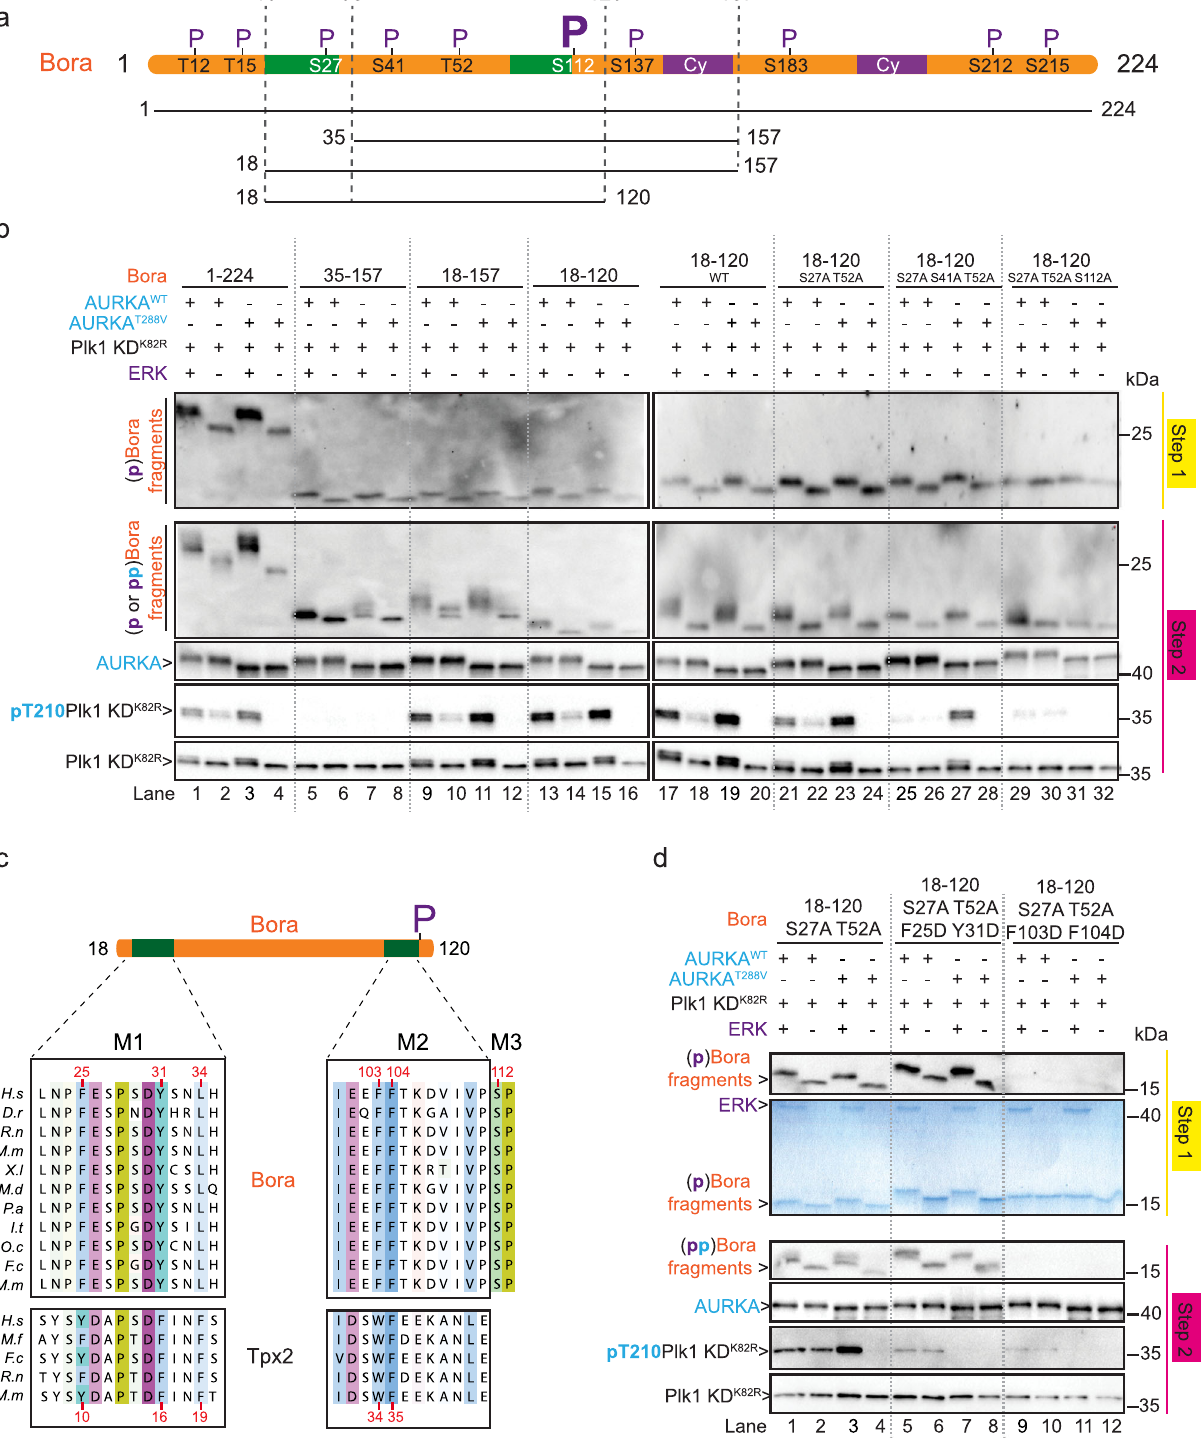
coordinating the phosphorylated T-loop residue T288 whereas only His176 is unique to coordinating the sulfate ion (Fig. 7a and Supplementary Fig.